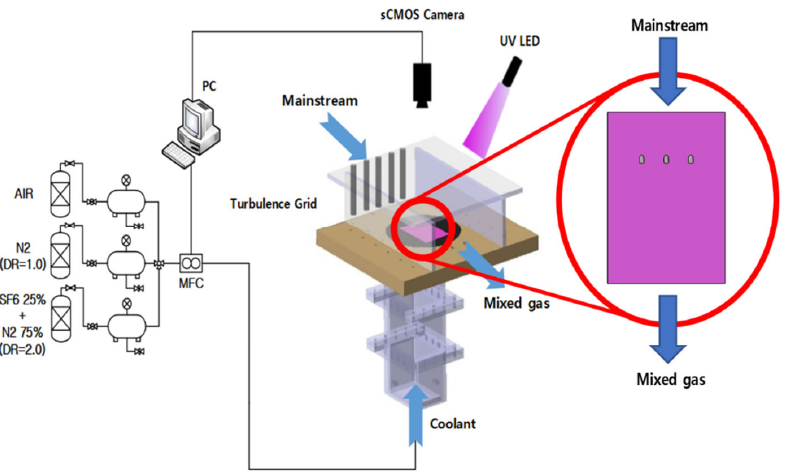
Figure 2. Schematic of film cooling test section [10]. Nitrogen (N 2 ) and a mixture of SF6 (75% of N2 + 25% of SF6) were used as the